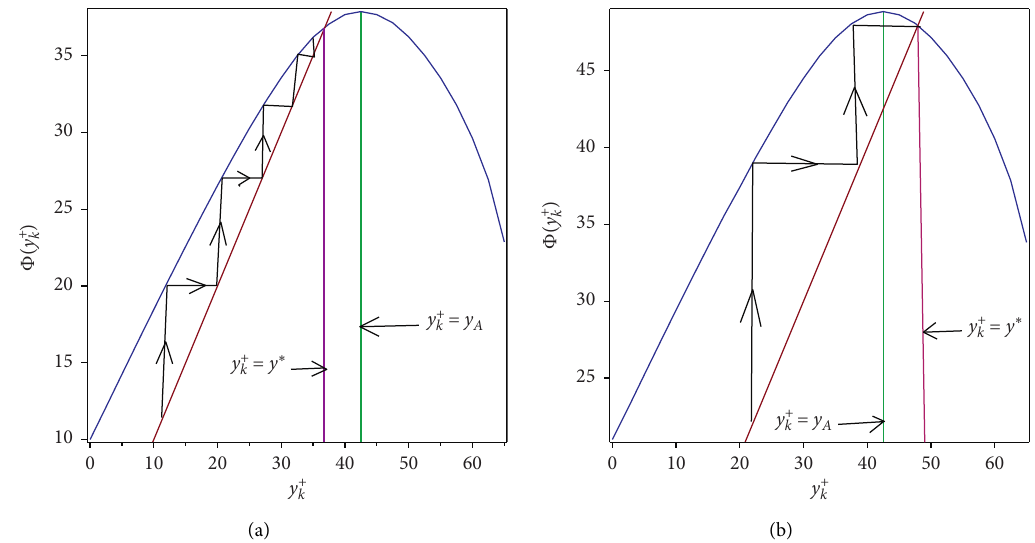
with r � 1 . 5 , K � 100 , m � 0 . 9 , α � 0 . 1 , d � 0 . 5 , β � 0 . 2 , a � 0 . 25 , b � 0 . 1 , and h � 40, k